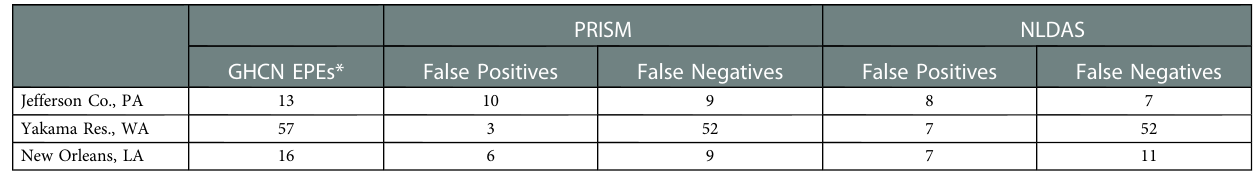
TABLE 7 Local examples of EPE false positives and false negatives – PRISM vs. GHCN, 2011 –